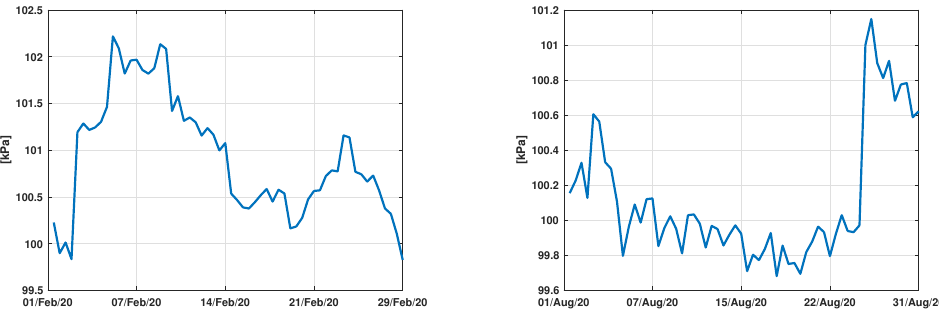
Figure 18. Site 2—Atmospheric pressure averaged values: February 2020 ( left ) and August 2020 ( right ).